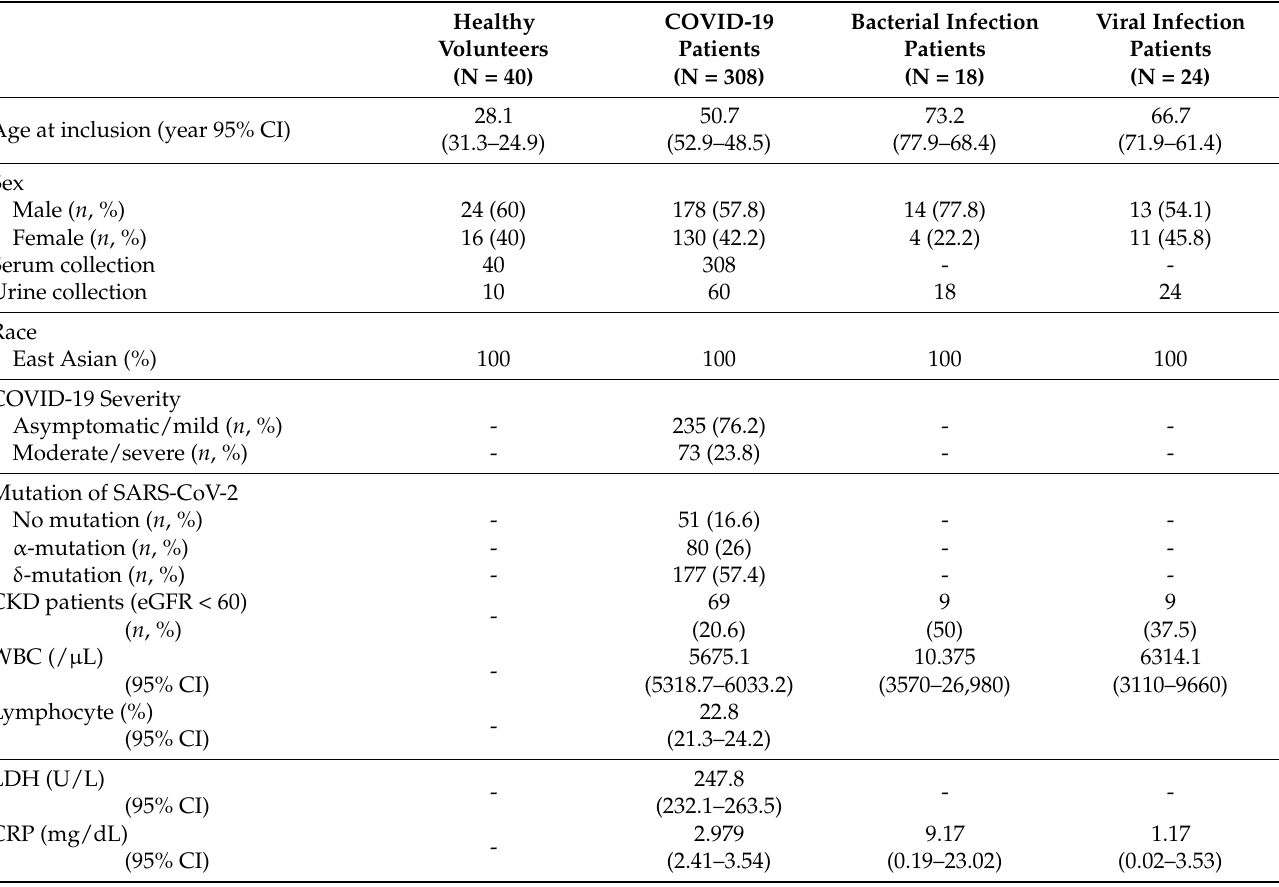
Table 1. Patient characteristics of this